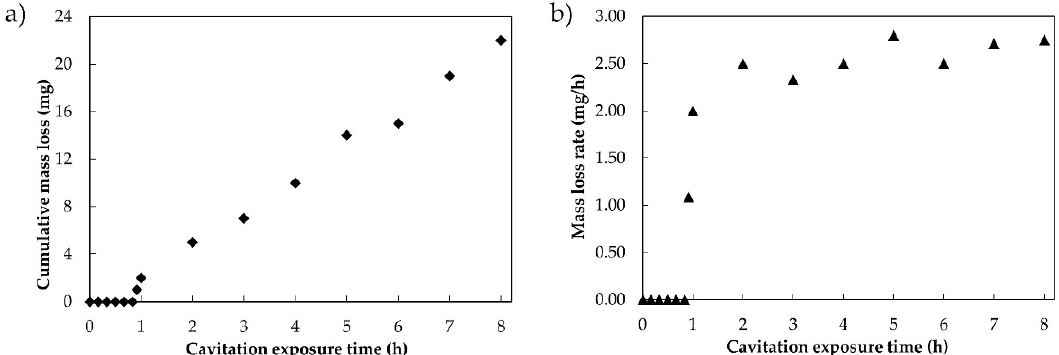
Figure 10. ( a ) Cumulative mass loss and ( b ) erosion rate during cavitation testing for the studied